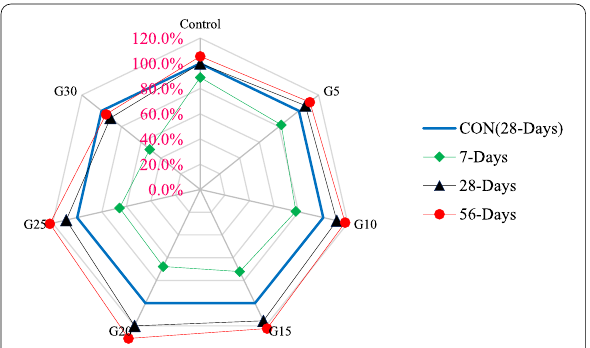
Fig. 13 Bond strength test results.